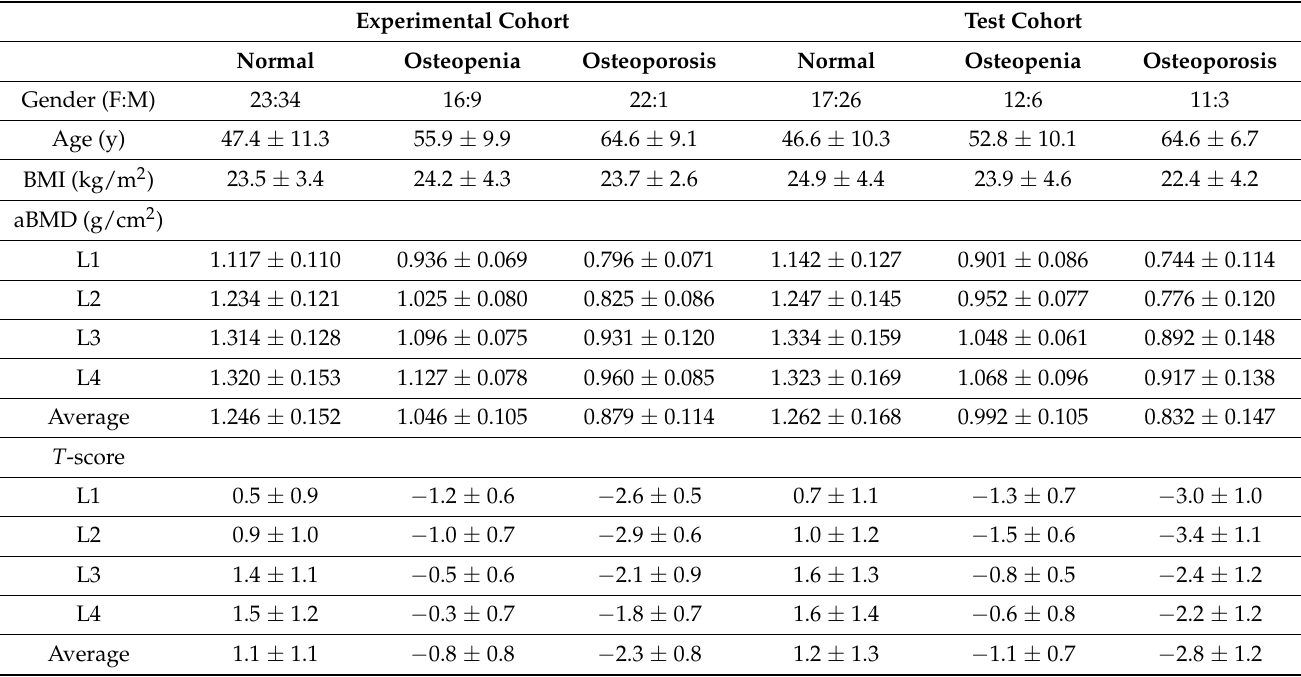
nificantly lower than that of men.